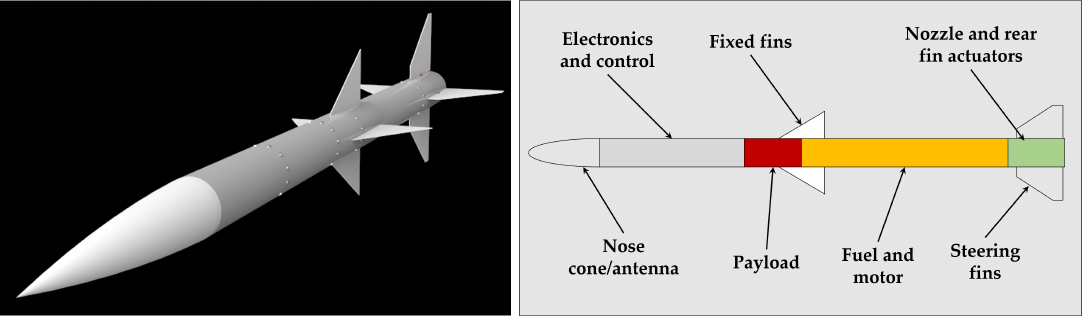
Figure 8. AIM-120 AMRAAM missile model [113,117]